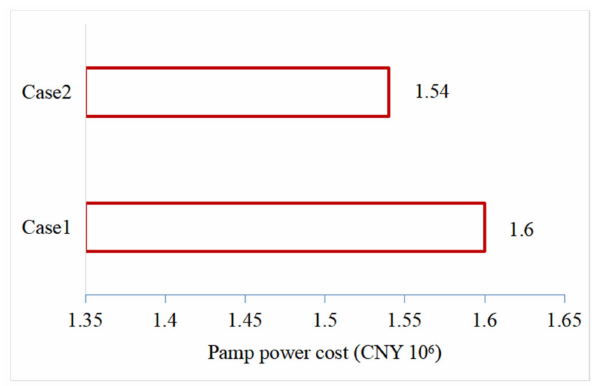
Figure 17. The ramp power cost of Case 1 and Case 2.